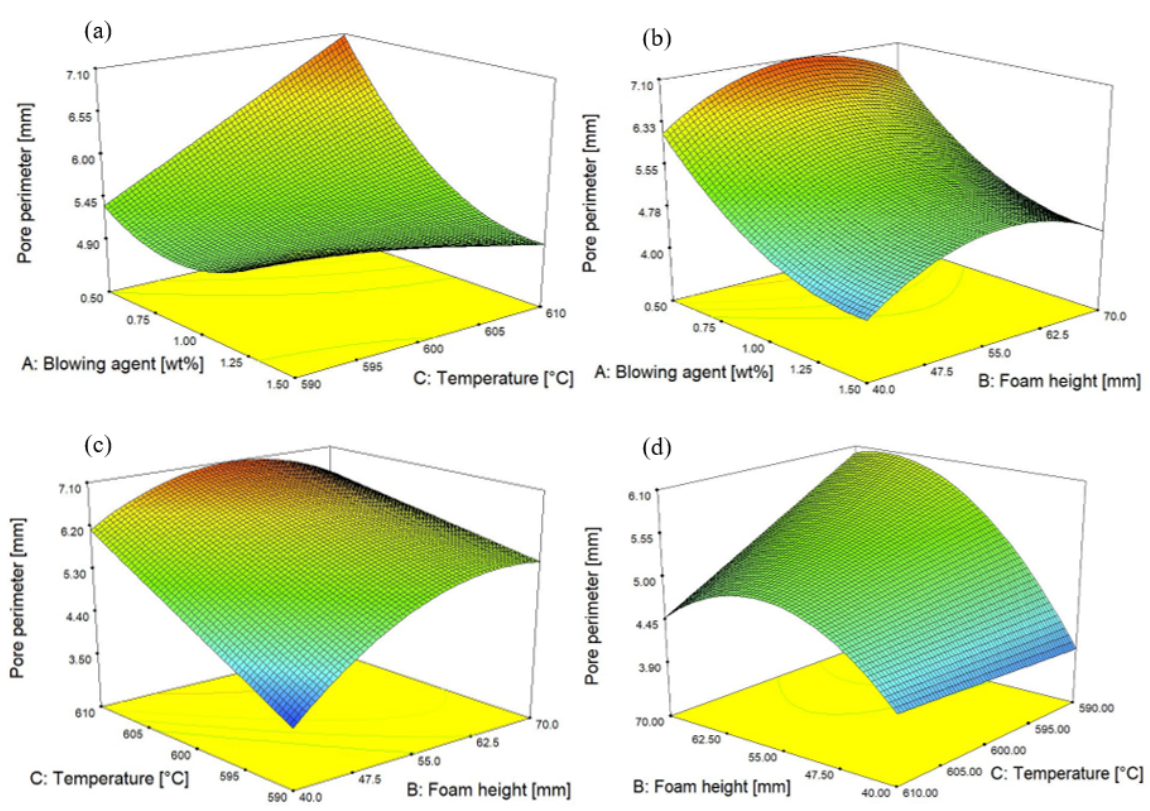
Figure 8. ( a ) Influence of blowing agent (wt%) and temperature on foam pore perimeter for a constant foaming height of 55 mm. ( b ) Influence of blowing agent (wt%) and foam height on foam pore perimeter for a constant foaming temperature of 610 °C. ( c , d ) Influence of the foaming temperature and foam height for constant (wt%) blowing agent of 0.5 and 1.5, respectively.